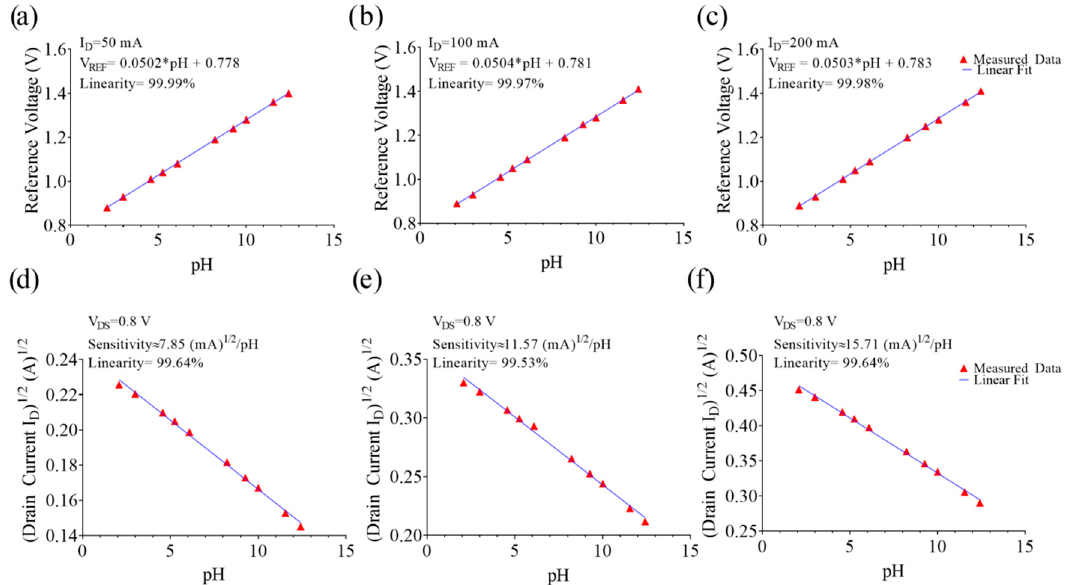
Figure 8. V Ref -pH response of the three EGFET-based prototypes evaluated in the linear region ( V DS = 0.9 V) for ( a ) I D = 50 mA (a = 47.5), ( b ) 100 mA (a = 95), and ( c ) 200 mA (a = 190). I D -pH response of the three EGFET-based prototypes evaluated in the saturation region ( V Ref = 0.9 V) for ( d ) a = 47.5, ( e ) a = 95, and ( c ) a = 190.